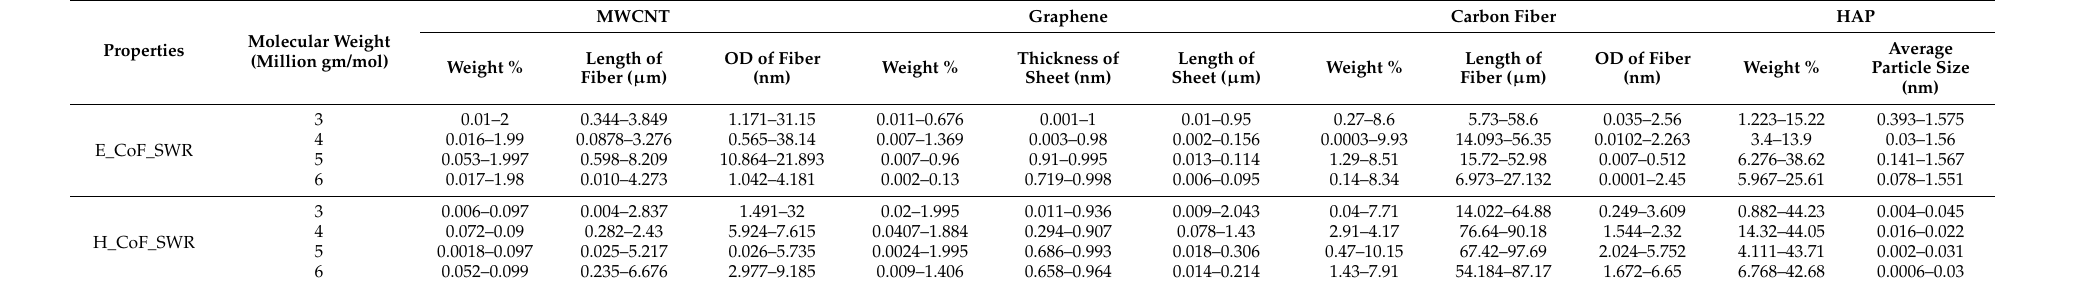
Table 3. Series of input variables of tribo-mechanical properties on varying molecular weight without